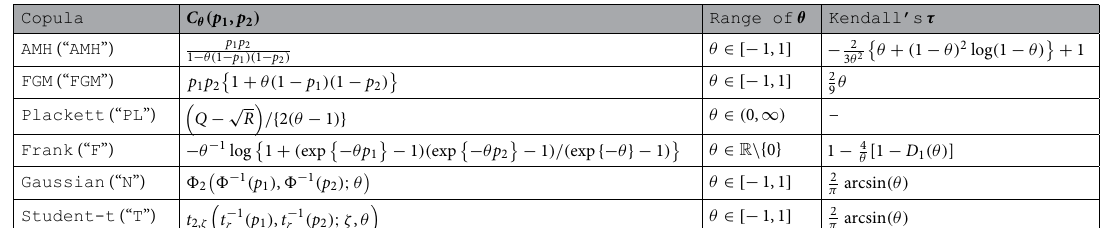
Table 1. Definition of the copulae implemented in GJRM , with corresponding parameter range of association parameter θ and relation between Kendall’s τ (which takes values in the customary range [− 1, 1 ] ) and θ . � 2 ( · , ·; θ) denotes the cumulative distribution function (cdf) of a standard bivariate normal distribution with correlation coefficient θ , and �( · ) the cdf of a univariate standard normal distribution. t 2, ζ ( · , ·; ζ , θ) indicates the cdf of a standard bivariate Student-t distribution with correlation θ and fixed ζ ∈ ( 2, ∞ ) degrees of freedom, and t ζ ( · ) denotes the cdf of a univariate Student-t distribution with ζ degrees of freedom. t dt is the Debye function and quantities Q and R are given by 1 + (θ − 1 )( p 1 + p 2 ) and D 1 (θ) = 1 (cid:31) θ θ 0 exp ( t ) − 1 Q 2 − 4 θ(θ − 1 ) p 1 p 2 , respectively. The Kendall’s τ for “ PL ” is computed numerically as no analytical expression is available. Argument BivD of gjrm() in GJRM allows the user to employ the desired copula function and can be set to any of the values within brackets next to the copula names in the first column; for example, BivD = “ N ”. More details of the copula functions used in this research can be found, for example, in Marra et al. and Nelsen 67